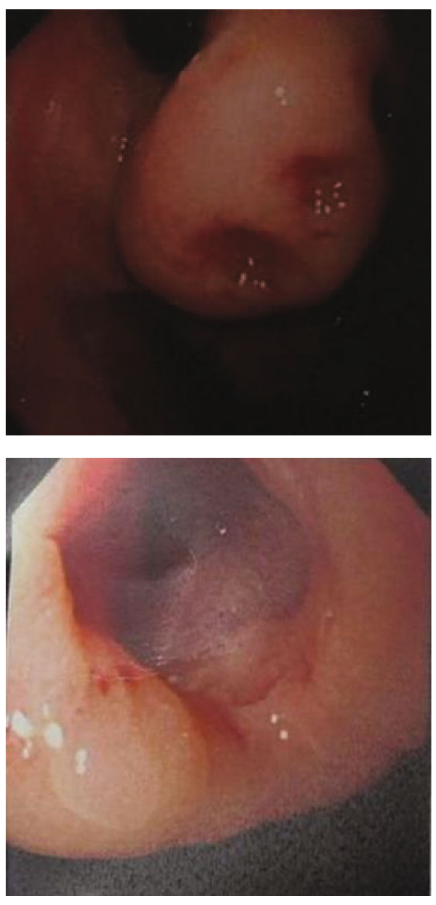
Figure 2: Upper gastrointestinal endoscopy revealed submucosal mass measuring 4.7cm, located at the cardia, with deep